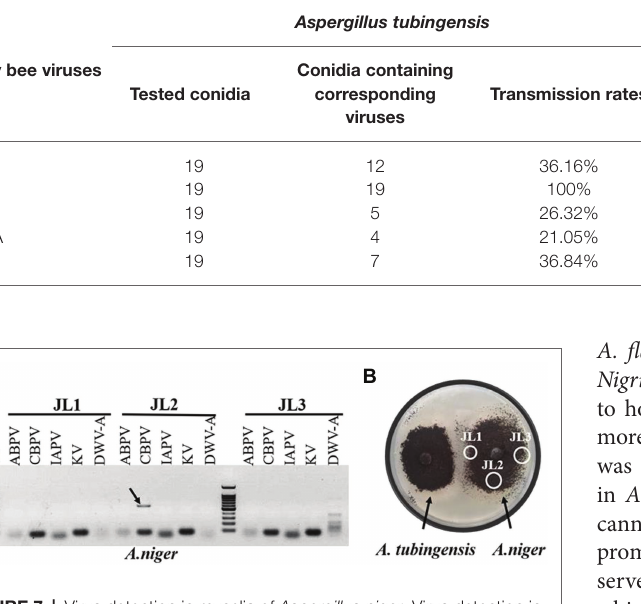
FIGURE 7 | Virus detection in mycelia of Aspergillus niger . Virus detection in mycelia of A. niger anastomosed with Aspergillus tubingensis (A) . Hyphal anastomosis between A. tubingensis and A. niger (B) . M: 100 bp DNA